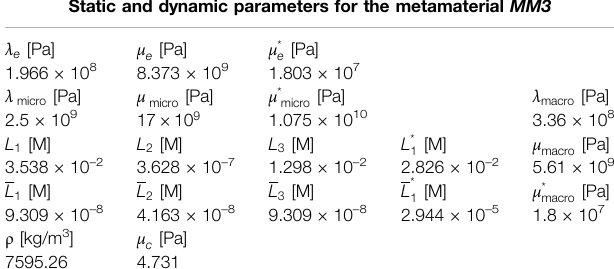
TABLE 3 | Static and dynamic parameters for the metamaterial MM3 . Panel (A) showsthevaluesoftherelaxedmicromorphicstaticanddynamicparametersfor the metamaterial MM3 determined via the fi tting procedures given in (d ’ Agostino et al., 2020; Aivaliotis et al., 2020). The apparent density ρ is computed based on the steel microstructure of Figure 2E . Panel (B) shows the values of the equivalent Cauchy continuum elastic coef fi cients corresponding to the long-wave limit of MM3 computed with the procedure explained in (Neff et al., 2020).